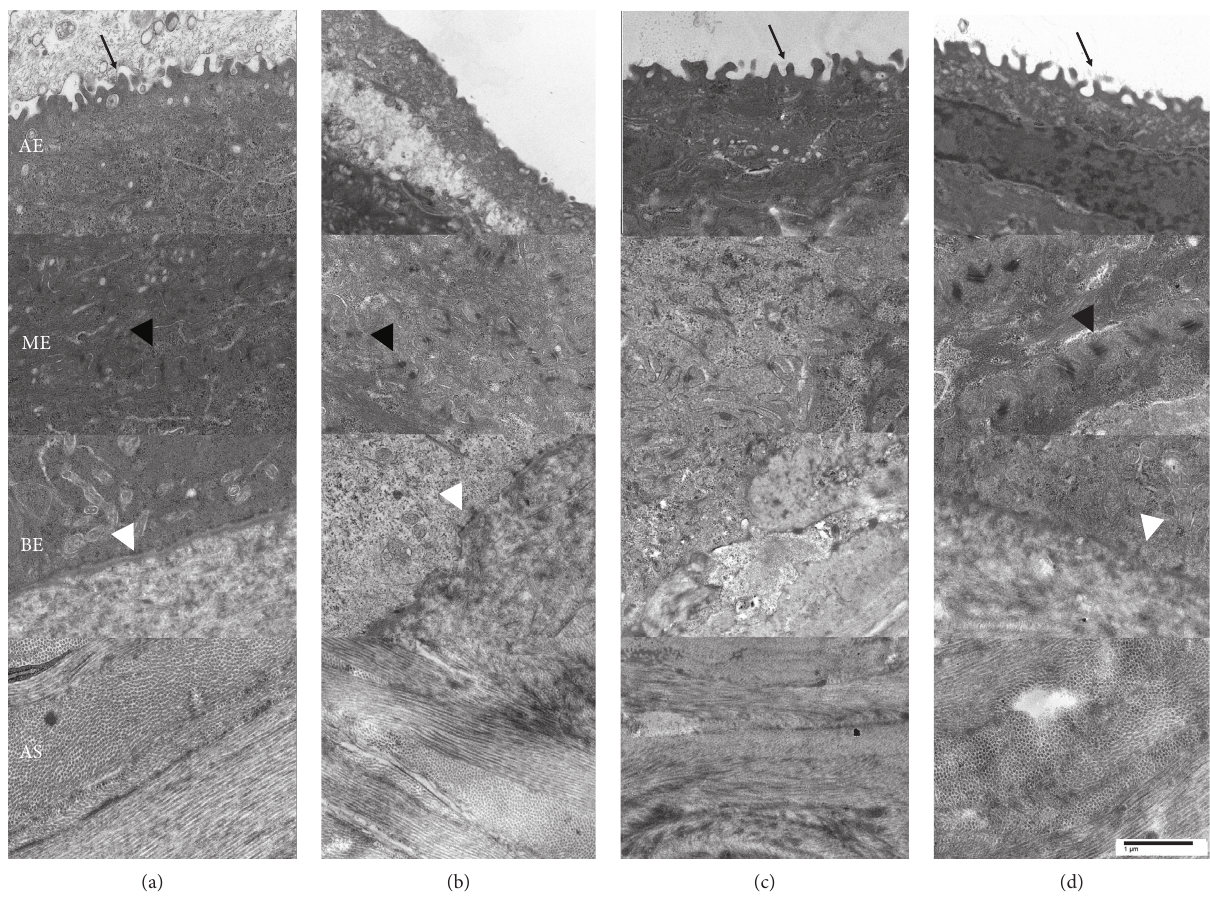
Figure 5: Representative TEM images. (a) Untreated eye, (b) eyes treated with control, (c) eyes treated with D-PRP, and (d) eyes treated with T-PRP. AE, atypical epithelium; ME, middle epithelium; BE, basal epithelium; AS, anterior stroma; black arrows, microvilli; black arrow heads, desmosome; white arrow heads, basal